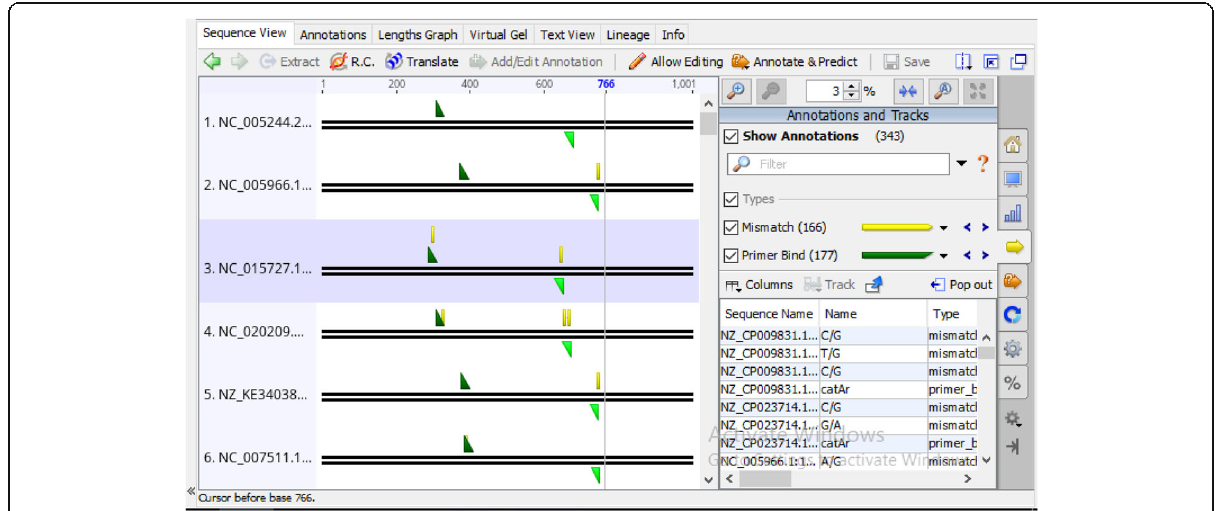
Fig. 10 In silico PCR result showing amplification of catechol 1,2-dioxygenases (C12O) gene with HYDEN designed degenerate primer catAf and catAr. The thick dark parallel non-overlapping lines in the figure represent both strands (Sense and antisense) of DNA in the orientation 5 ’ -3 ’ and 3 ’ -5 ’ respectively. The right-angle triangles depict the primers. Green right-angle triangles indicate primer-template binding in the 5 ’ region of the sense strand while inverted olive green right-angle triangle illustrates primer-template binding in the 5 ’ region of the antisense strand. All yellow figures depict mismatches between sequences in the primers and target